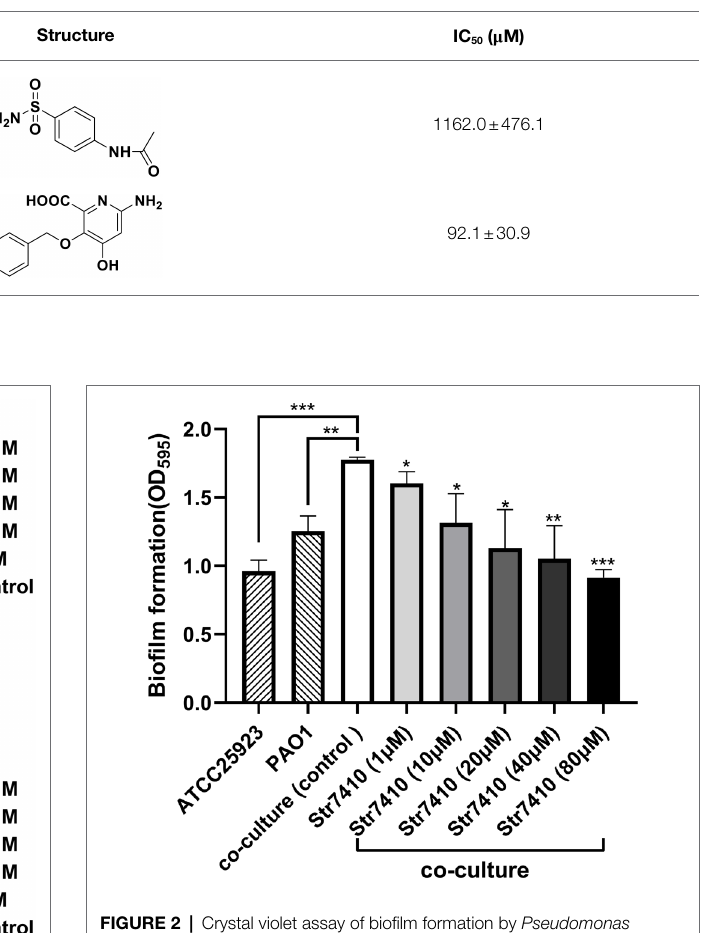
FIGURE 2 | Crystal violet assay of biofilm formation by Pseudomonas aeruginosa PAO1 and Staphylococcus aureus ATCC 25923 alone and in co-culture after 24 h, and the inhibitory effect of compound Str7410 on biofilm formation by the mixed culture. Values are the mean ± SD ( n = 3). Differences in data were compared with the untreated control at each time-point and considered significant when p < 0.05 (* p < 0.05, ** p < 0.01, and *** p < 0.001) by one-way ANOVA with t -tests. TABLE 3 | Minimal inhibitory concentration (MIC) and minimum biofilm inhibitory concentration (MBIC) of antibiotics toward planktonic and biofilm cells of